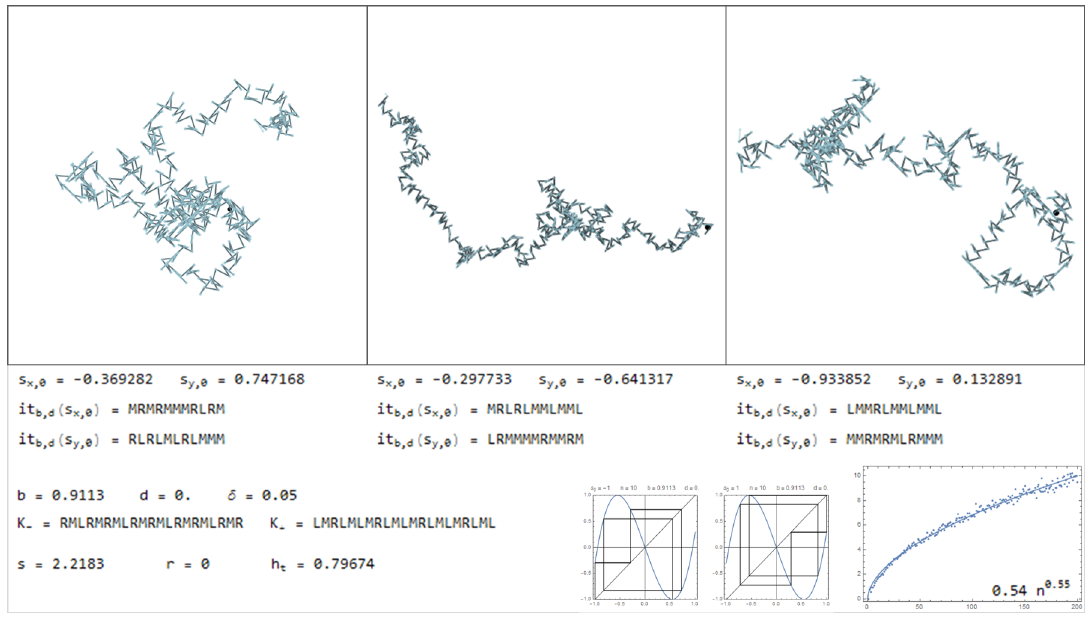
Figure 14. Trajectories produced with b = 0.9113 and d = 0.